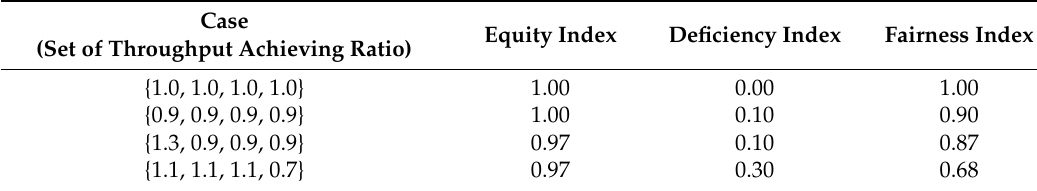
Table 2. Fairness Index of Sample